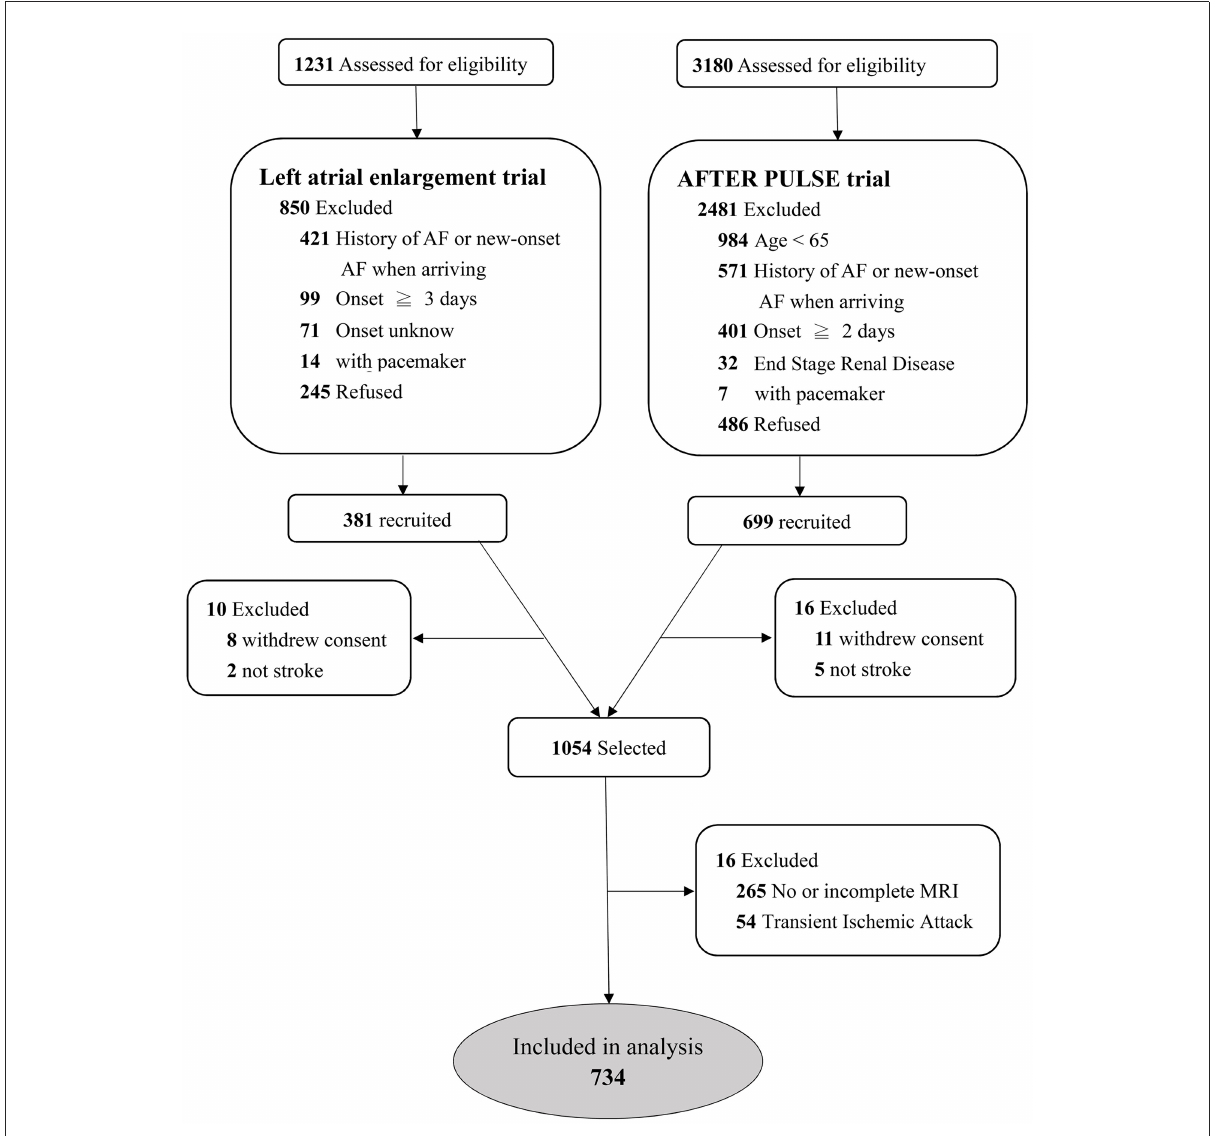
FIGURE1 Study flowchart of patient selection.